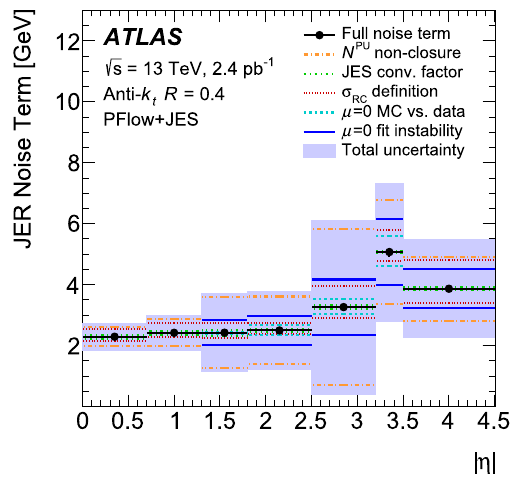
Fig. 28 Noise term due to pile-up estimated using the random cone methodanditsuncertaintiesasafunctionof η .Thedominantuncertainty is due to non-closure in the method. Additional uncertainties address the σ RC definition, the JER conversion factor, the differences in JER between data and MC simulation, and the fit stability in extracting the μ = 0noiseterm.The σ μ = 0MCvsdata RC definitionuncertaintyand terms are asymmetric in their upwards and downwards components, while all other uncertainties are symmetrized